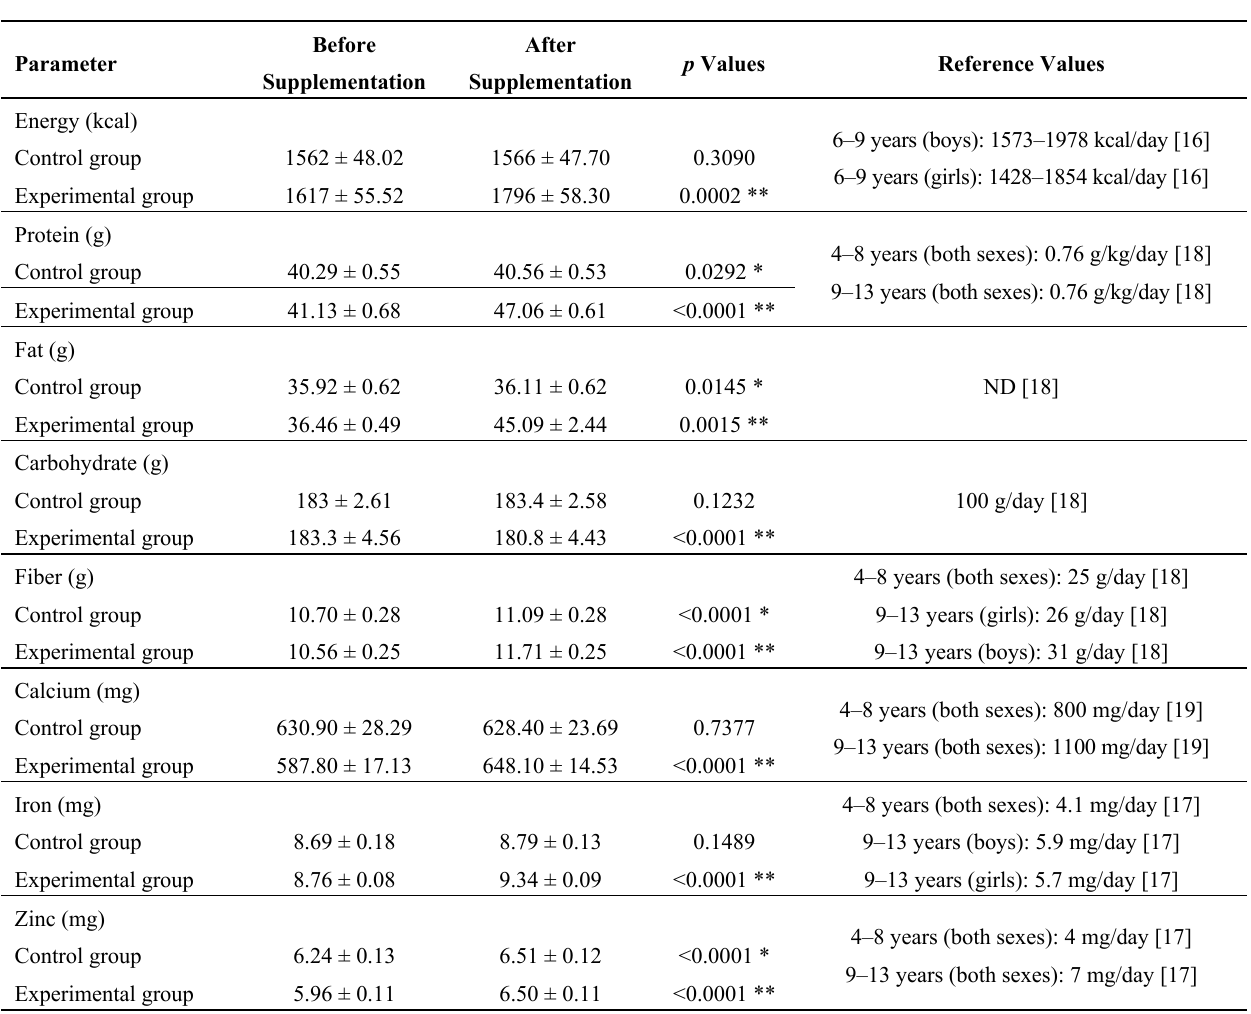
Table 2. Energy and nutrient intake before and after oral zinc supplementation (experimental group) or placebo (control group) compared with recommended intakes for age and sex in 30